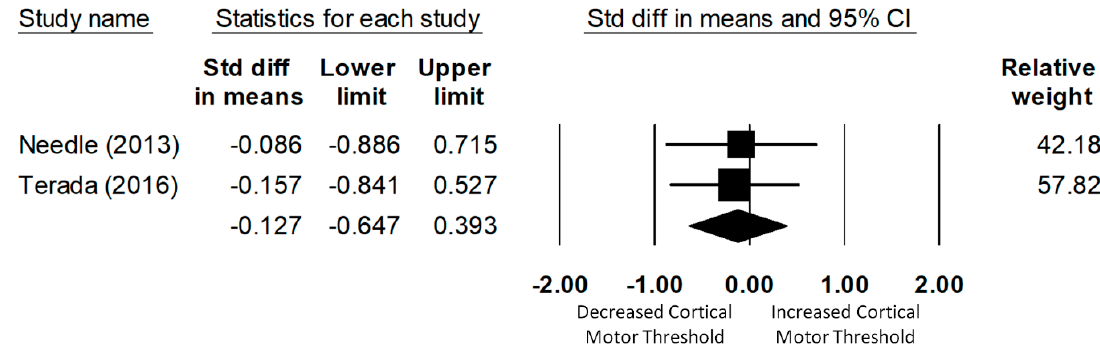
Figure 4. Forest plot illustrating Cohen’s d effect sizes for the soleus cortical motor threshold between groups with and without CAI and their 95% confidence intervals.